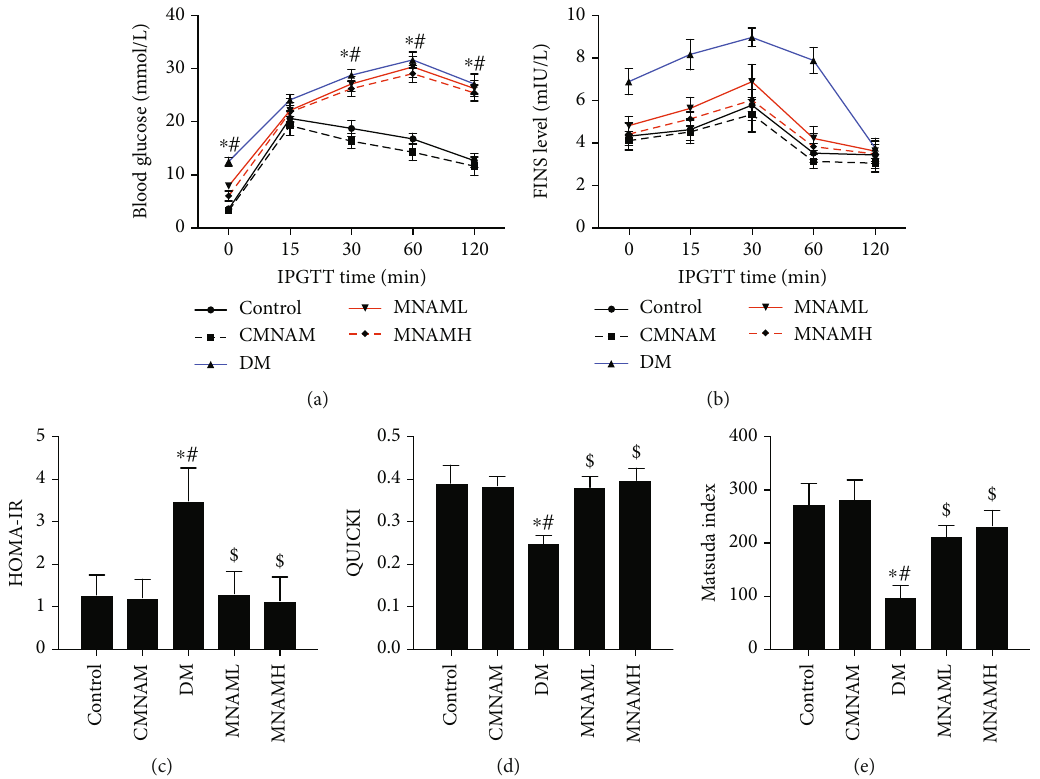
Figure 2: MNAM enhances insulin sensitivity in obese type 2 diabetic mice ( n = 10 ). (a) Blood glucose after IPGTT of mice in each group; (b) insulin levels after IPGTT of mice in each group; (c) HOMA-IR data; (d) insulin sensitivity index — QUICKI data; (e) Matsuda index data. ∗ Compared with the control group, P < 0 : 05 ; # compared with the CMNAM group, P < 0 : 05 ; $ compared with the DM group, P < 0 : 05